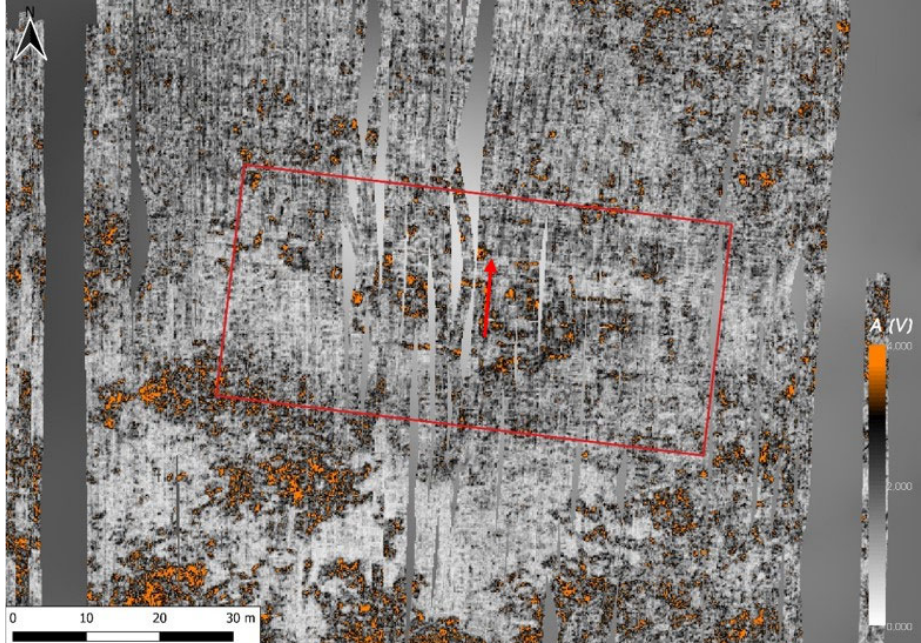
Figure 6. Detail of the central area (Area 2) at − 0.5 m depth. Above, a small quadrangular anomaly. Below, the large rectangular structure with its compartmentalised zones. The red arrow indicates the area chosen for the radargram analysis (Figure 7).